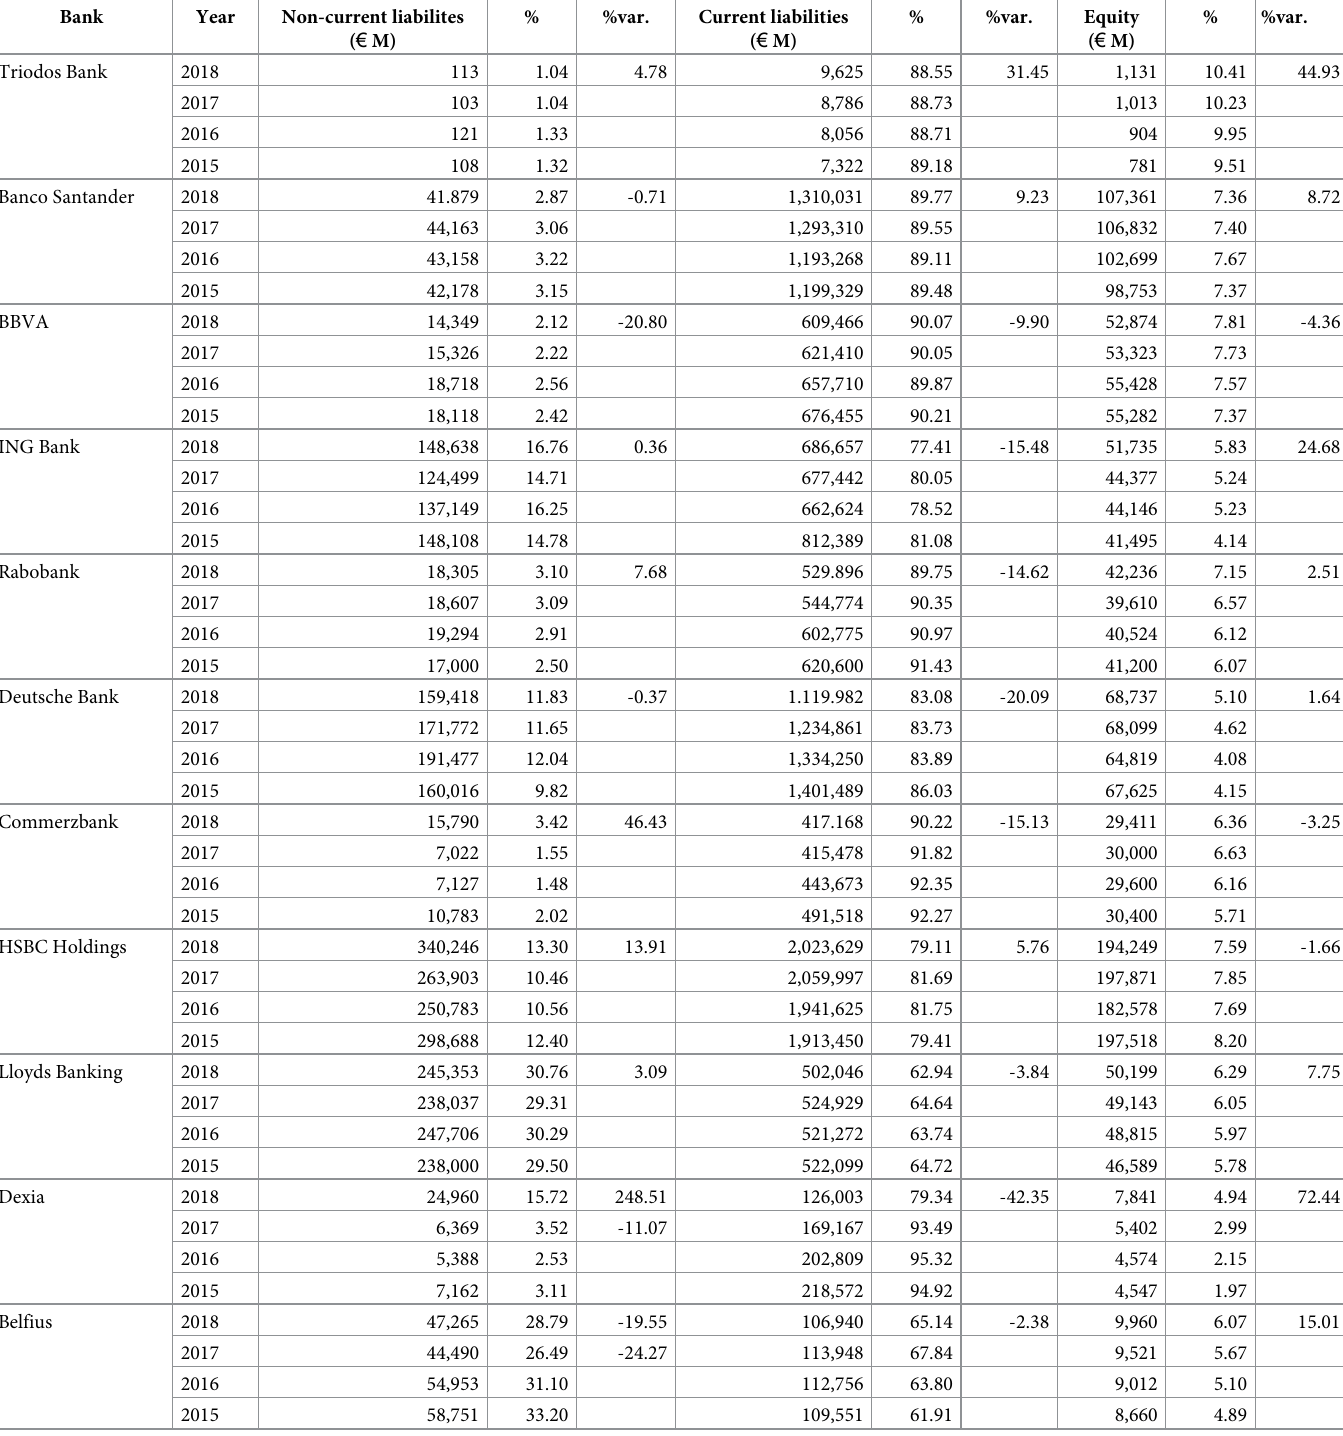
Table 5. Comparison of equity and liabilities.